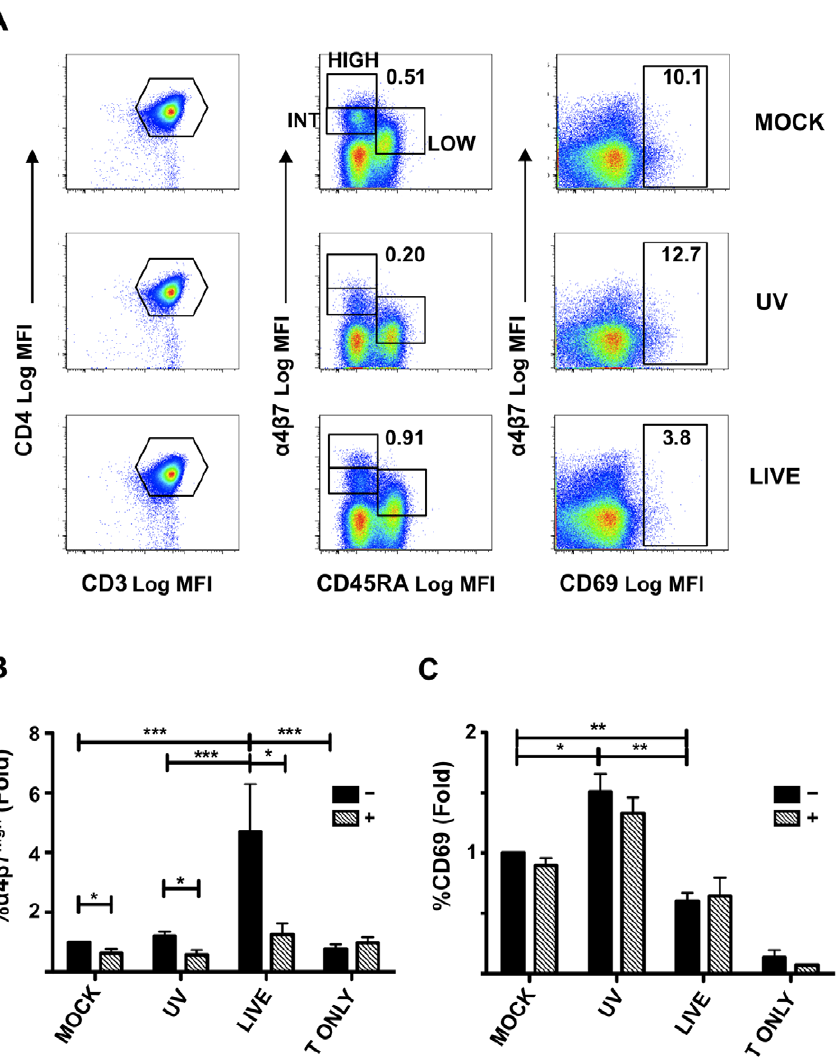
Figure 4. HSV-2 infection of moDCs induces a 4 b 7 on CD4 + T cells. Mock-, UV-HSV-2-, or Live HSV-2-treated DCs (Figure 3) were mixed with autologous CD4 + T cells and cultured for 5 days. A) The gating strategy for the definition of the a 4 b 7high (HIGH) (memory cells), a 4 b 7int (INT) (memory cells) and a 4 b 7low (LOW) (naı¨ve cells) and CD69 + subsets is shown for 1 representative of 11 independent experiments. B–C) The fold changes (mean 6 SEM, 11 independent experiments) in the percentage of a 4 b 7high CD3 + CD4 + T cells (B) and CD69 + CD3 + CD4 + T cells (C) in the absence ( 2 ) or presence ( + ) of an RAR a antagonist are shown relative to the mock-treated controls (set as 1). A T cell only control (no DCs, T ONLY), not exposed to HSV-2, was included alongside. (*p , 0.05, ** , 0.01, ***p # 0.001).